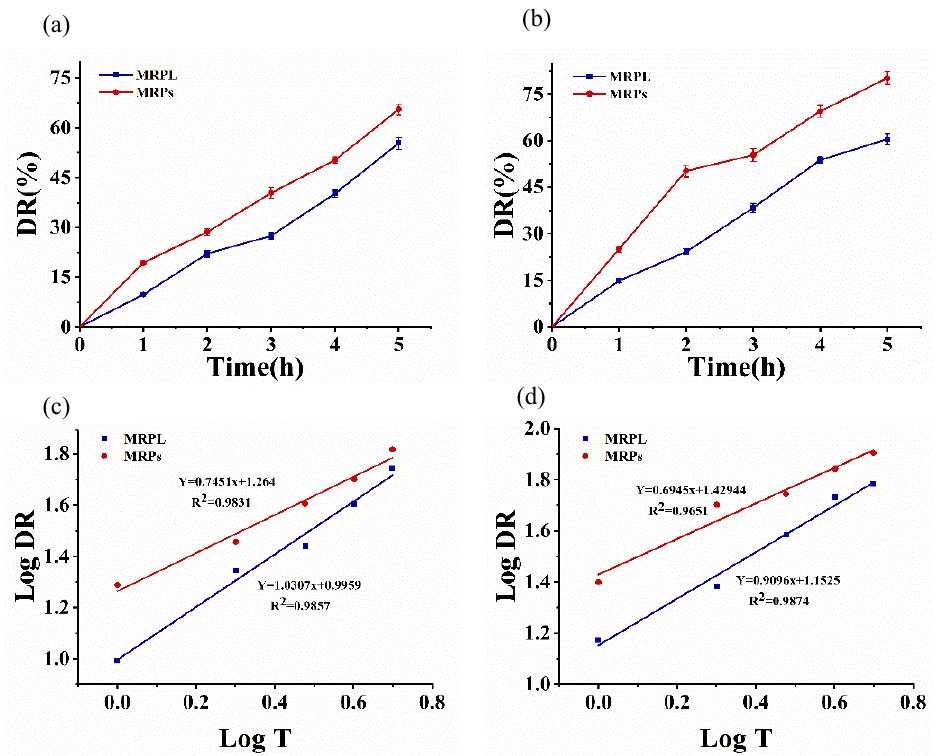
Figure 3. In vitro release of free MRPs and MRPL and Korsmeyer–Peppas kinetics. ( a ) Release in SGF of free MRPs and MRPL; ( b ) release in SIF of free MRPs and MRPL; ( c ) Korsmeyer–Peppas kinetics of release in SGF; ( d ) Korsmeyer–Peppas kinetics of release in SIF. Table 1. Regression equation of four drug ‐ release kinetic models in simulated gastrointestinal en ‐